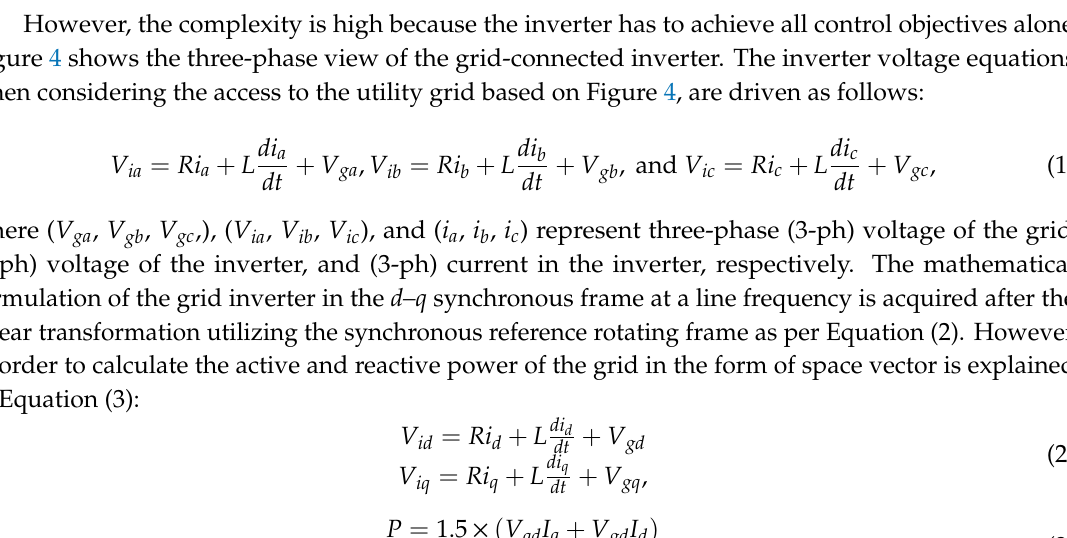
Figure 4. Three-phase (3-ph) view of the grid-connected voltage source inverter.